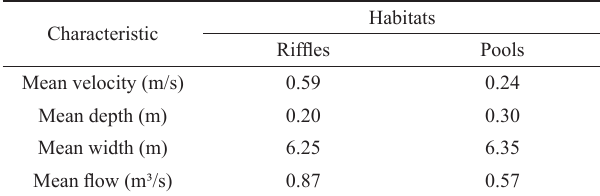
Tab. 2. Physical characterization of the habitat types